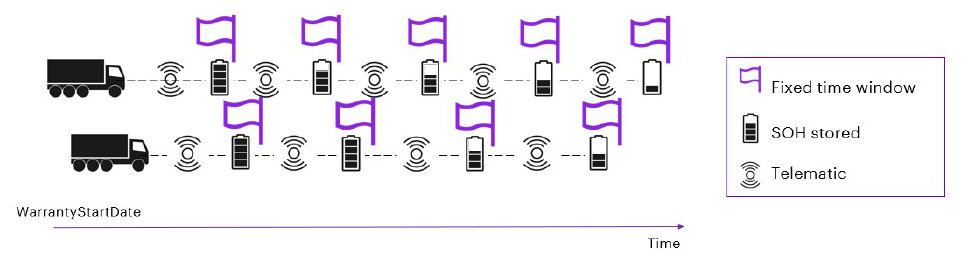
Figure 13. Time window